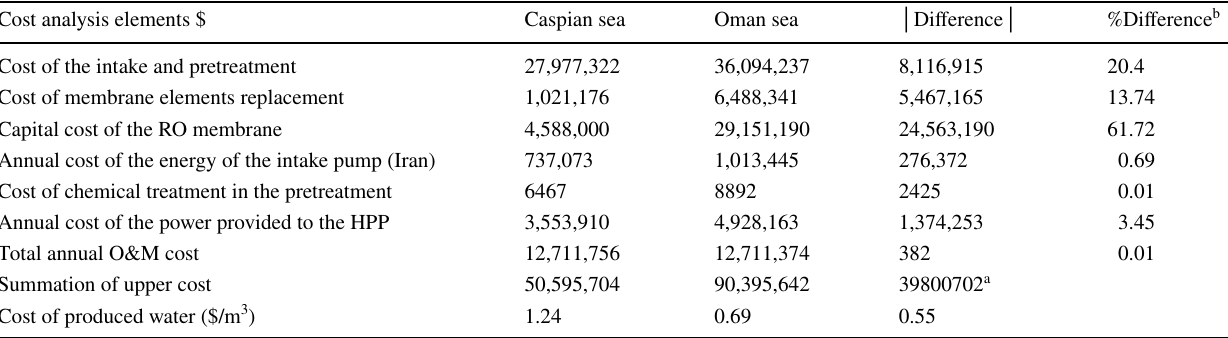
Table 3 Comparative Cost Analysis of conceptual RO desalination plant with capacity of 200,000 m 3 /day for two different intake water of Cas- pian and Oman sea (using membrane element DOW filmtec